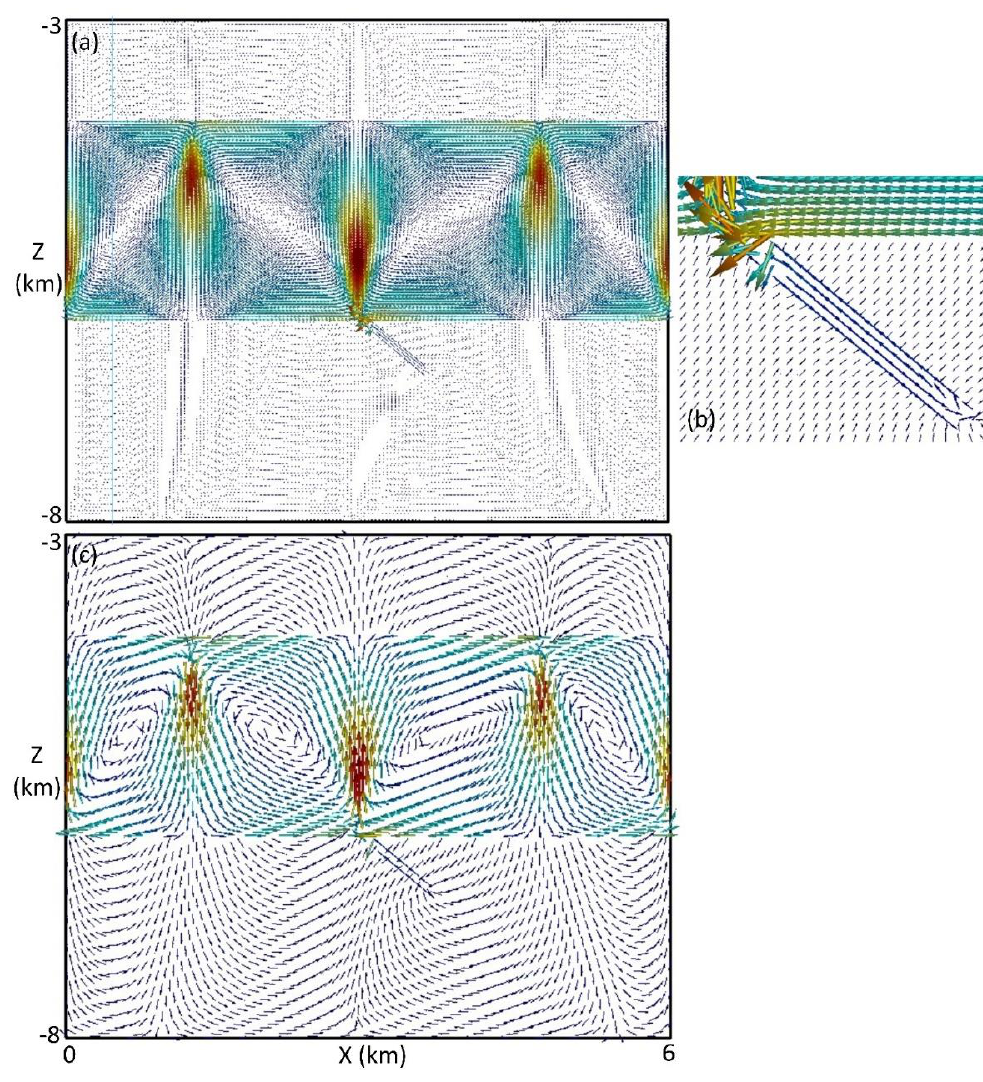
Figure 2. Numerical results of the fluid flow vectors at 10,000 years for Scenario 1: ( a ) the original flow vectors, ( b ) the enlarged view of the flow vectors surrounding the fault zone, and ( c ) the flow vectors that are sparsely sampled and artificially adjusted in length.